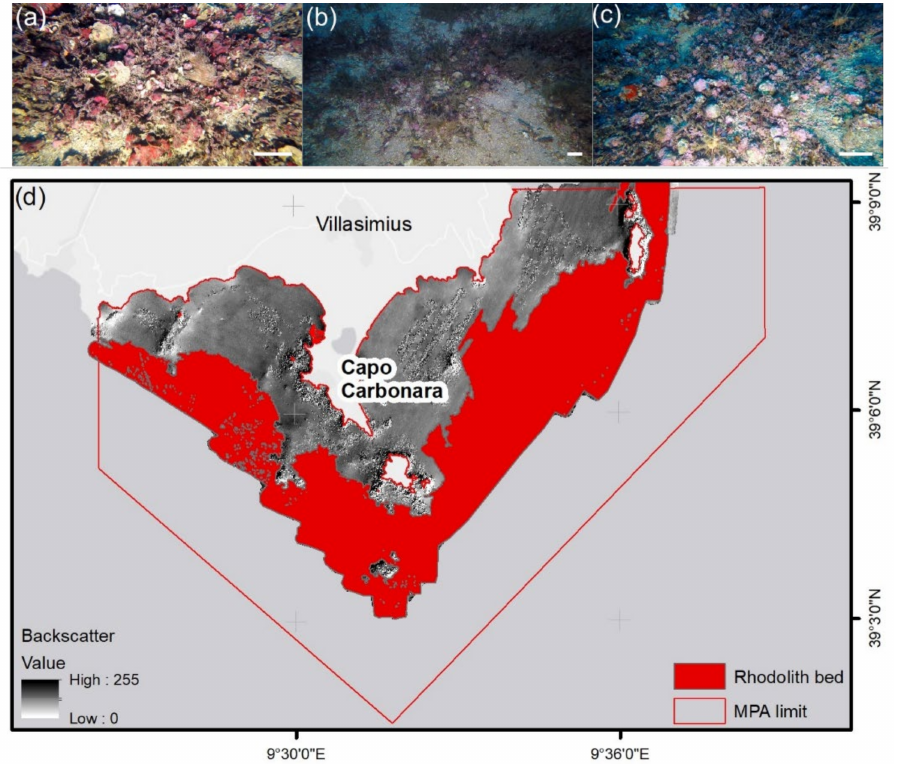
Figure 2. ( a ) Is Piscadeddus, ( b ) Santa Caterina, and ( c ) Serpentara video frames extracted from the ROV survey certifying the occurrence of a live and well-developed rhodolith bed. The scale bar indicates 5 cm. ( d ) map of the rhodolith bed in the MPA “Capo Carbonara”. Service layer credit in ( d ): Esri, HERE, Garmin, (C) OpenStreetMap